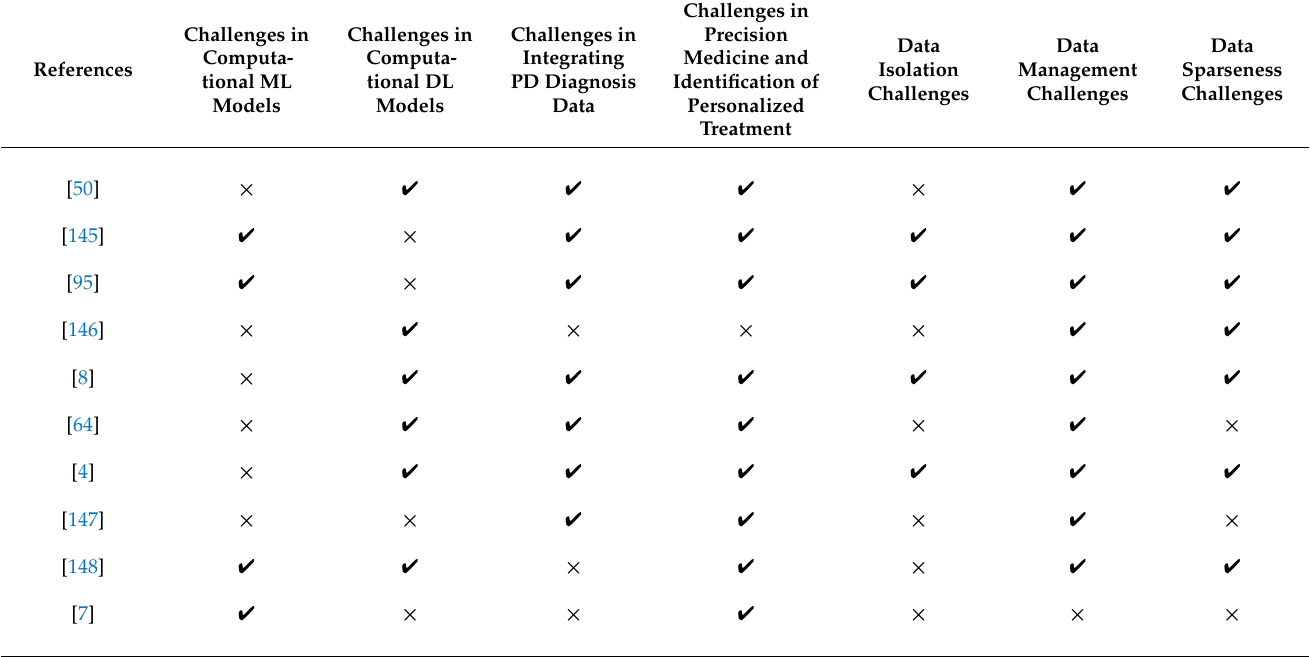
Table 7. Open Challenges for Parkinson’s Disease